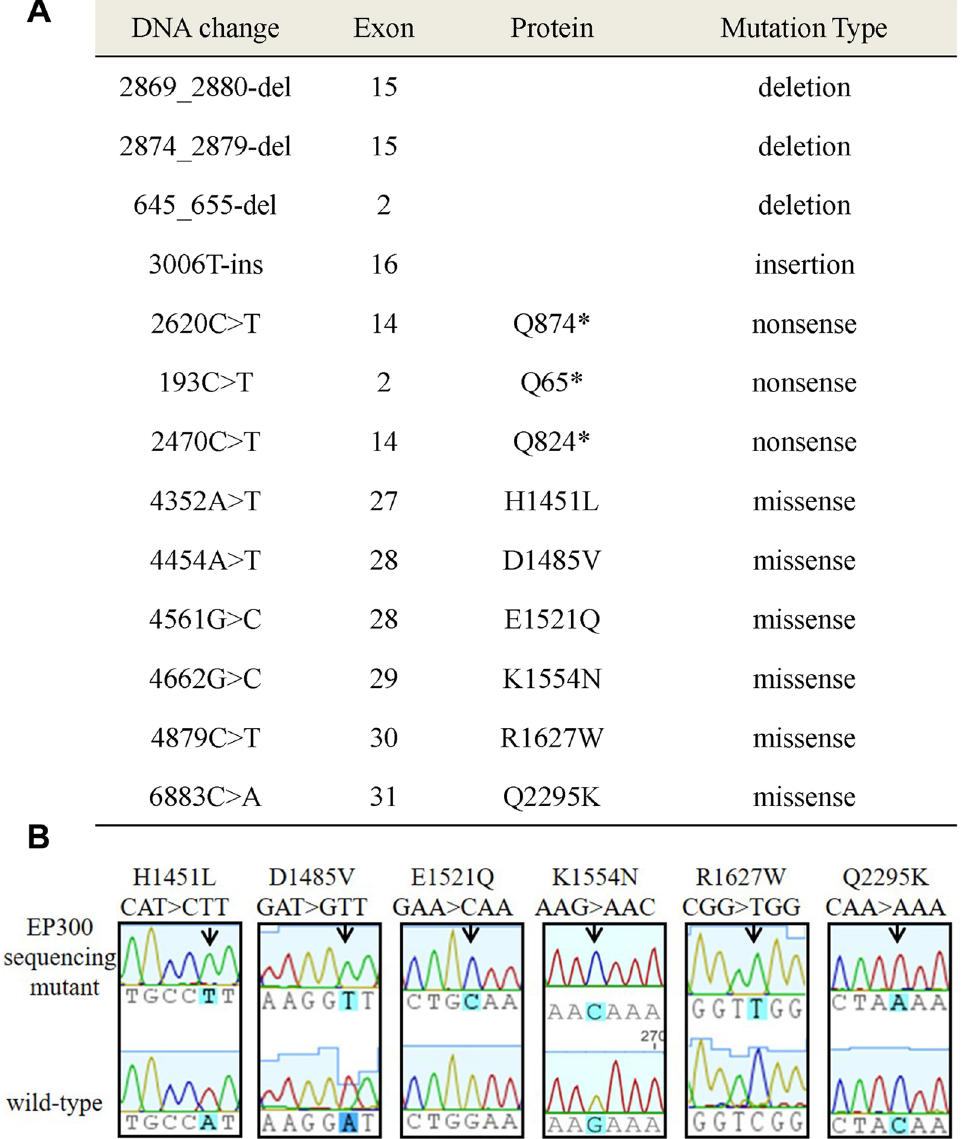
Fig. 1 High-throughput sequencing of 97 cases with TCC. A High-throughput sequencing of bladder cancer reveals 13 non-synonymous gene lesions in EP300. B Sequencing traces of representative mutations and corresponding wild-type EP300 constructs. Arrows point to the position of the nucleotide change. Amino acid changes are shown at the